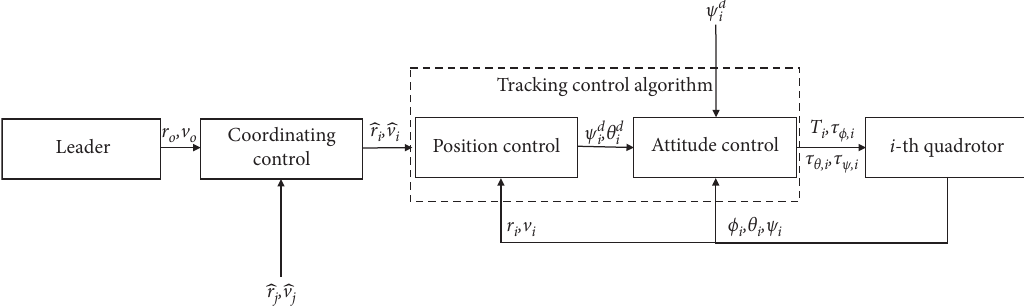
Figure 1: The diagram of hierarchical formation